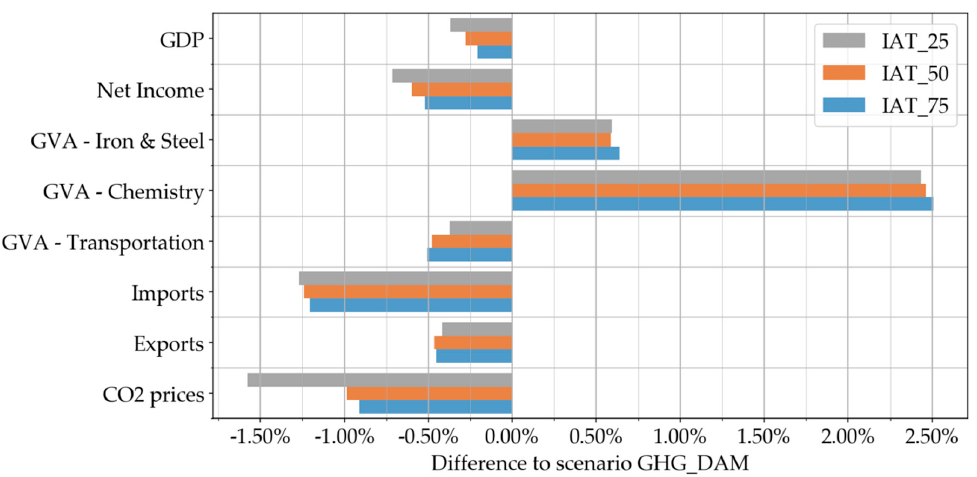
Figure 12. Difference of selected economic variables in the EU28 compared to GHG_DAM in 2050.